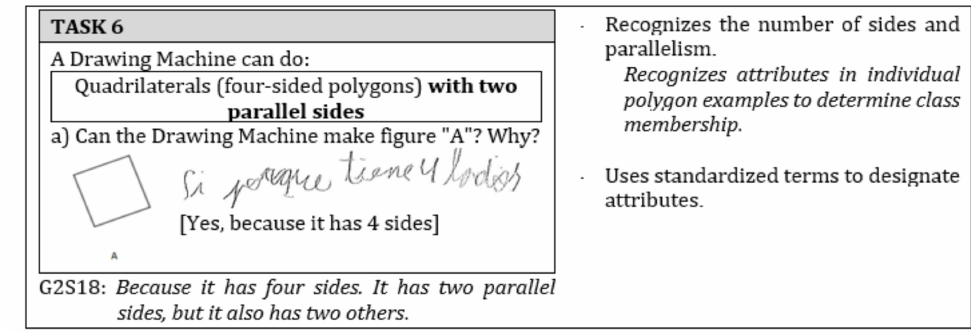
Figure 6. Memo of the solution of student G2S18 when performing the task of recognize polygon attributes (initial interview).